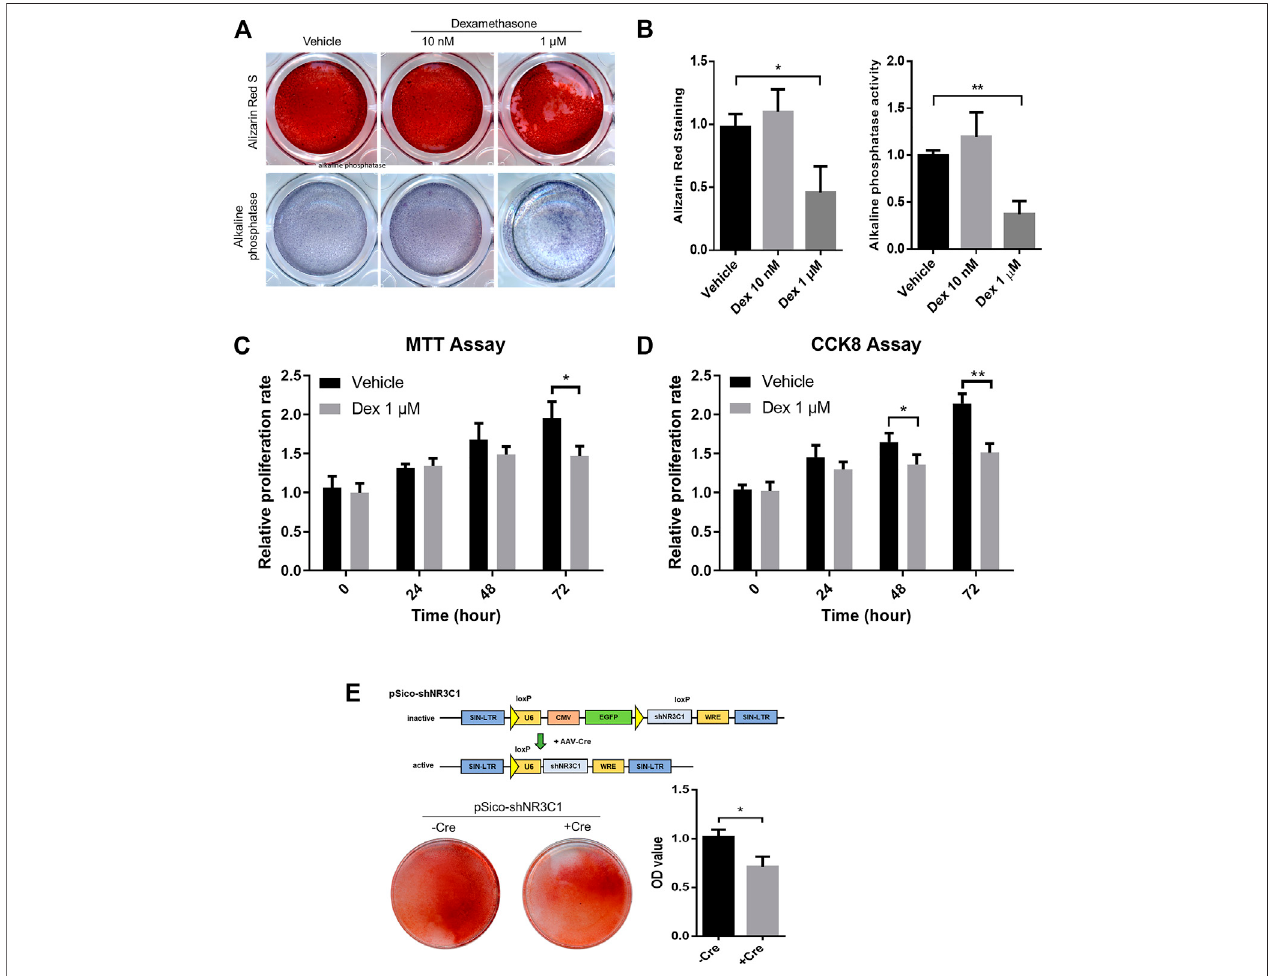
FIGURE 5 | Micromolar levels of dexamethasone prevented osteogenesis and proliferation in pre-conditioned MSCs. (A,B) Alizarin Red staining and alkaline phosphatasestainingofMSC-derivedosteoblastculture. (C,D) MTTassayandCCK-8assayofMSCsduringthe72 h-intervalofDexpreconditioning. (E) Cre-mediated silencing of NR3C1 rescued the osteogenic effect of MSCs which had subjected to Dex pre-conditioning. * p < 0.05, ** p < 0.01, signi fi cant between groups.